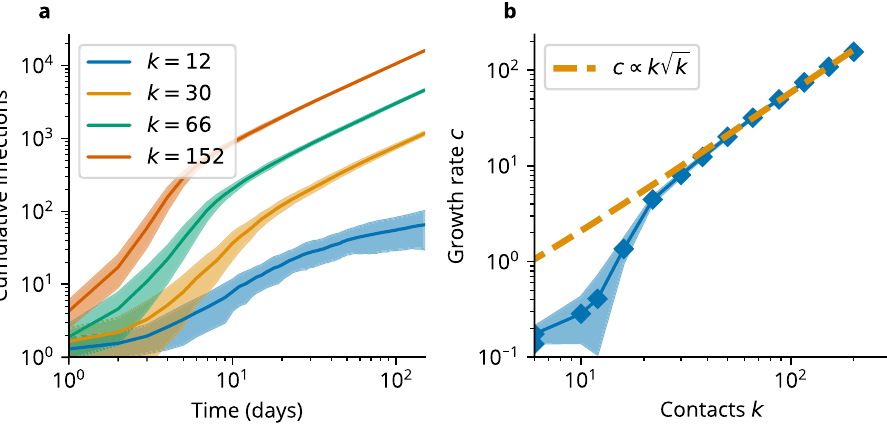
Figure 5. Comparison of model dynamics and mean-field approximation in the linear regime. ( a ) Cumulative number of infections in the model for a highly clustered network ( p infections in dependence of the number of contacts k . The growth rate scales as c field theory for a large number of contacts k , see Eq. (2). Shown is the mean and standard error of the mean (SEM) of 20 independent simulations for each